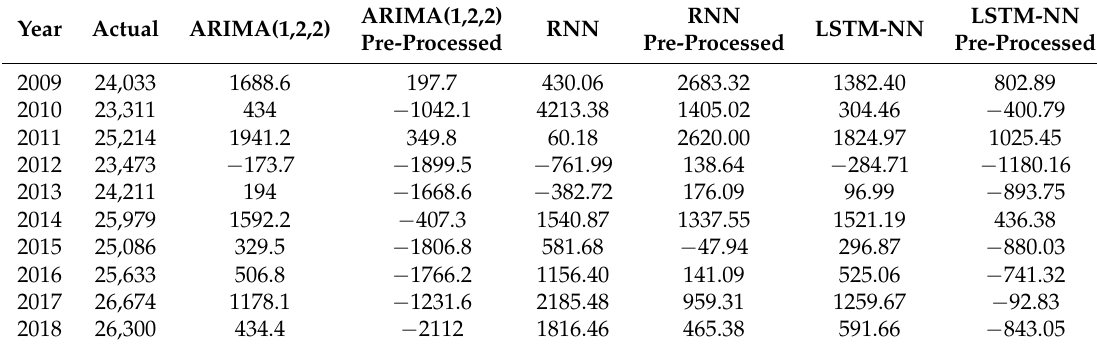
Table 4. The difference between actual and forecast wheat production (in thousand tons) for years 2009–2018 using various models.